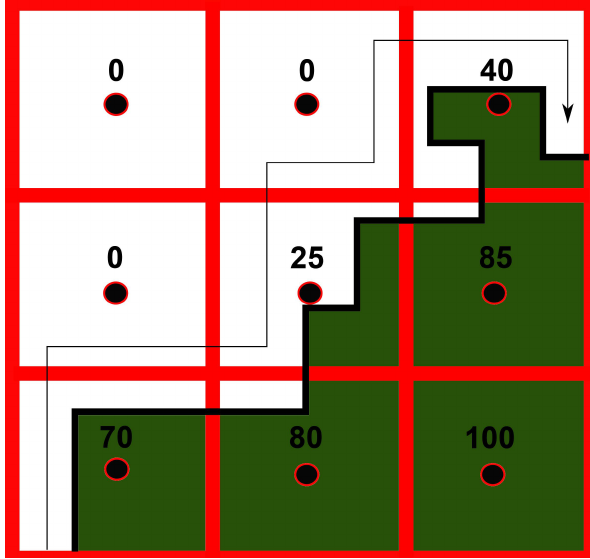
Figure 2. Method of sub-pixelization and pixel jurisdiction in a field of 9 x 9